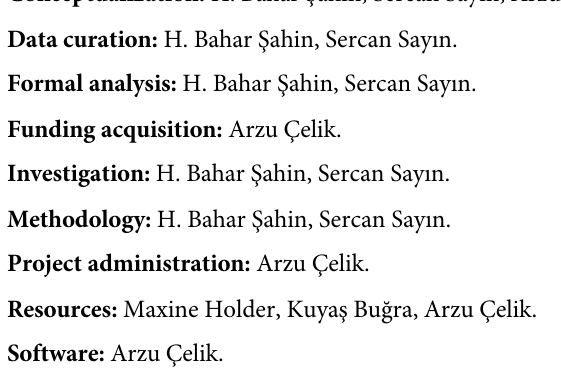
S1 Table. Eye phenotypes in sensitized and eyeful background. The eye phenotype quantifi- cation (A-A 0 ) in the “sensitized” ( Delta overexpression) and (B-B 0 ) in the “eyeful” backgrounds ( Delta overexpression in combination with GS88A8 epigenetic regulator mutation). Percent- ages for different backgrounds are (A,B) listed in the table and (A 0 ,B 0 ) shown in the histogram. The baseline eyes are similar to the sensitized parents’, which is slightly bigger than the wild type flies. The affected eyes are subclassified as fold / overgrowth (bigger eyes with at least one fold, or overgrowth of the eye), ectopic-eyes (ectopic eye tissue on the head surface or split- eyes on one side of the head), eye loss (total loss of the eye tissue), and metastasis (ectopic eye tissue in the body or in the head, which is not exposed on the surface). The incidences of nor- mal eyes and affected eyes were quantified, and the ratio over the total number of eyes is pre- sented in the table. (A,B) The total ratio of affected eyes is shown in the last column for each background, together with the standard error of the mean obtained from 3 independent trials. The genotypes are as in Fig 1. The full genotypes are listed in S2 Table. (PDF) S2 Table. The full genotypes used in this study. (DOCX) S3 Table. Potential Sik targets in Drosophila proteome. This data is supplied in an Excel table. Notch pathway members are marked with pink. Other interesting targets are marked with